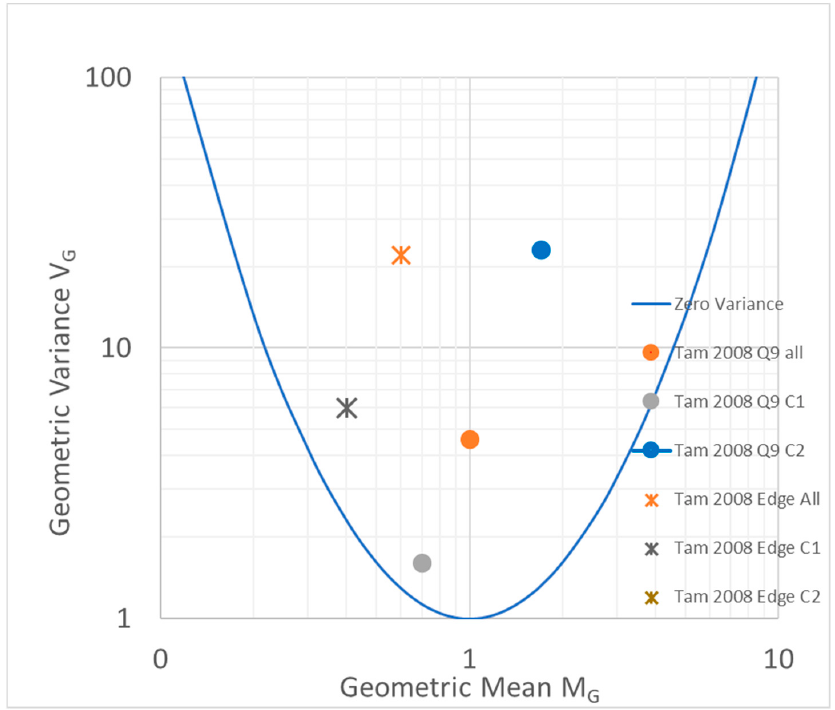
Figure 8. MV diagram showing performance of the Q9 model based on work carried out towards the Tam 2008 paper. The solid circles show results in which Q9 volumes were derived directly from experimental data (published in [2]). The crosses are results in which Q9 volumes are placed near the edge of the module. The variance of the blue cross is so large that it is outside the boundary of this figure. Note about legend: a line is added to the start of a new symbol to allow its easy